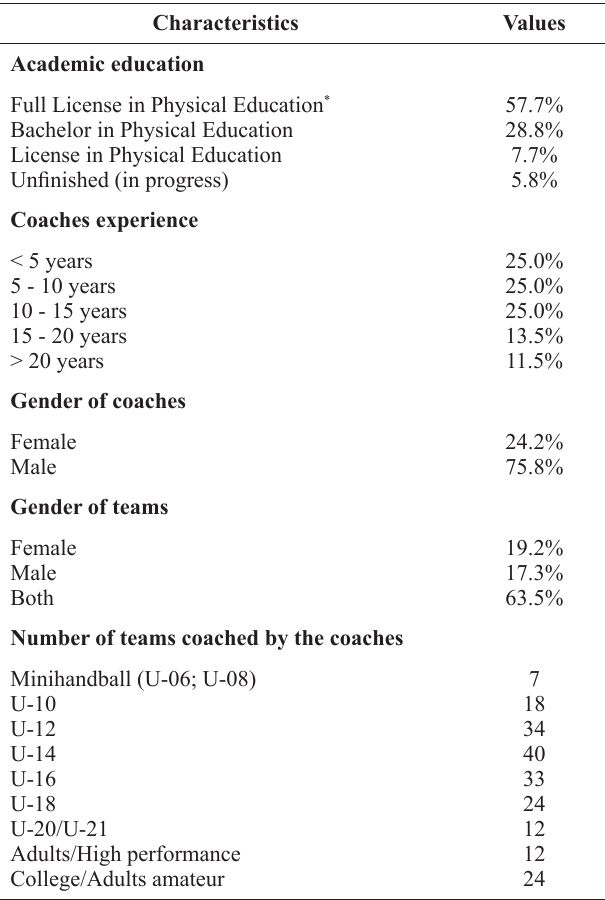
Table 1 - General characteristics of the coaches